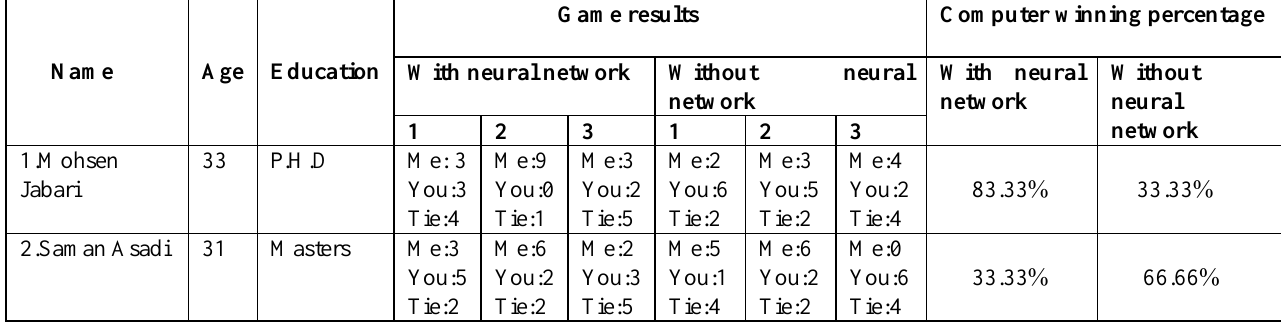
Game results and computer winning percentage in men with and without neural network.